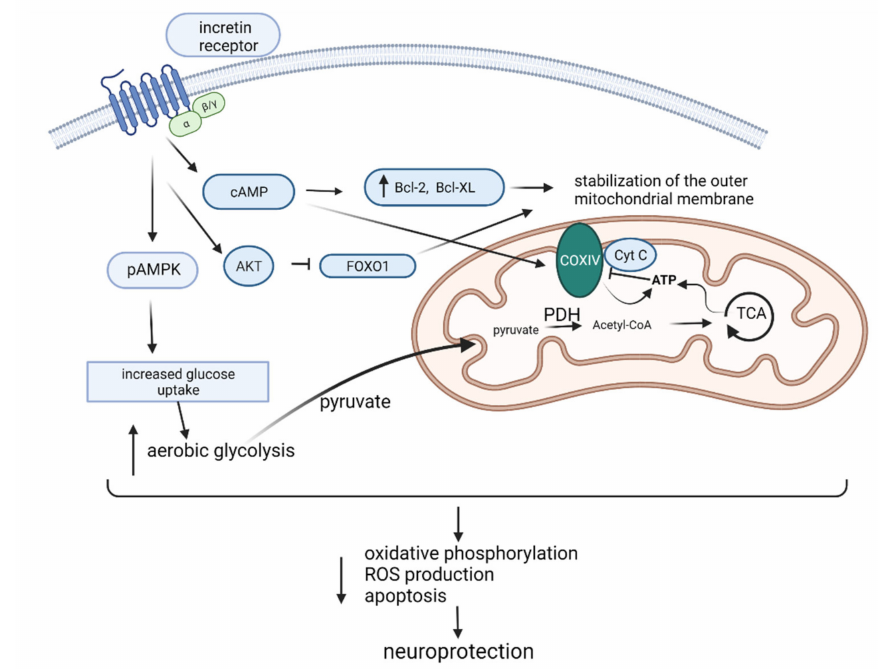
Figure 1. The underlying mechanism responsible for the beneficial effect of incretins in Alzheimer’s disease. Incretin receptor activation may include stabilization of the outer mitochondrial membrane, prevention of cytochrome c (CytC) efflux into the cytoplasm, and reduction of apoptosis and oxidative stress through activation of cAMP and other kinases. Together with ATP, the cAMP-dependent, protein kinase A (PKA) signaling pathway can regulate cytochrome c oxidase (COXIV) activity and mitochondrial function [22]. It can also activate AMP-activated protein kinase (AMPK), leading to increased glucose uptake by the cells in an insulin-independent manner. By increasing aerobic glycolysis, pyruvate is converted to acetyl-CoA by pyruvate dehydrogenase (PDH), which enters the citric acid cycle (TCA) to produce ATP. In this way, incretins shift the cell metabolism from oxidative phosphorylation and increased ROS production to aerobic glycolysis, leading to a neuroprotective effect. FOXO1—forkhead box protein O1; AKT—protein kinase B; Bcl—B-cell lymphoma. Figure created with BioRender.com (accessed on 27 December